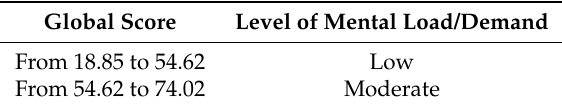
Table 3. Assessment table for the global NASA-TLX